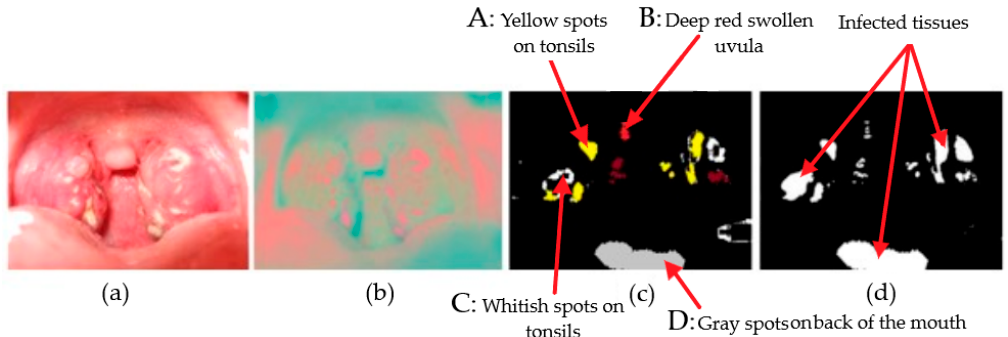
Figure 12. Strep detection procedure based on YCbCr components of a throat image: ( a ) Original RGB image, ( b ) YCbCr image converted from the RGB image in (a), ( c ) infected tissue detected in (b), and ( d ) infected tissue marked in white color. Table 2. Mean and standard deviation of YCbCr avg values in the A, B, C, and D regions from all healthy and diseased throats.